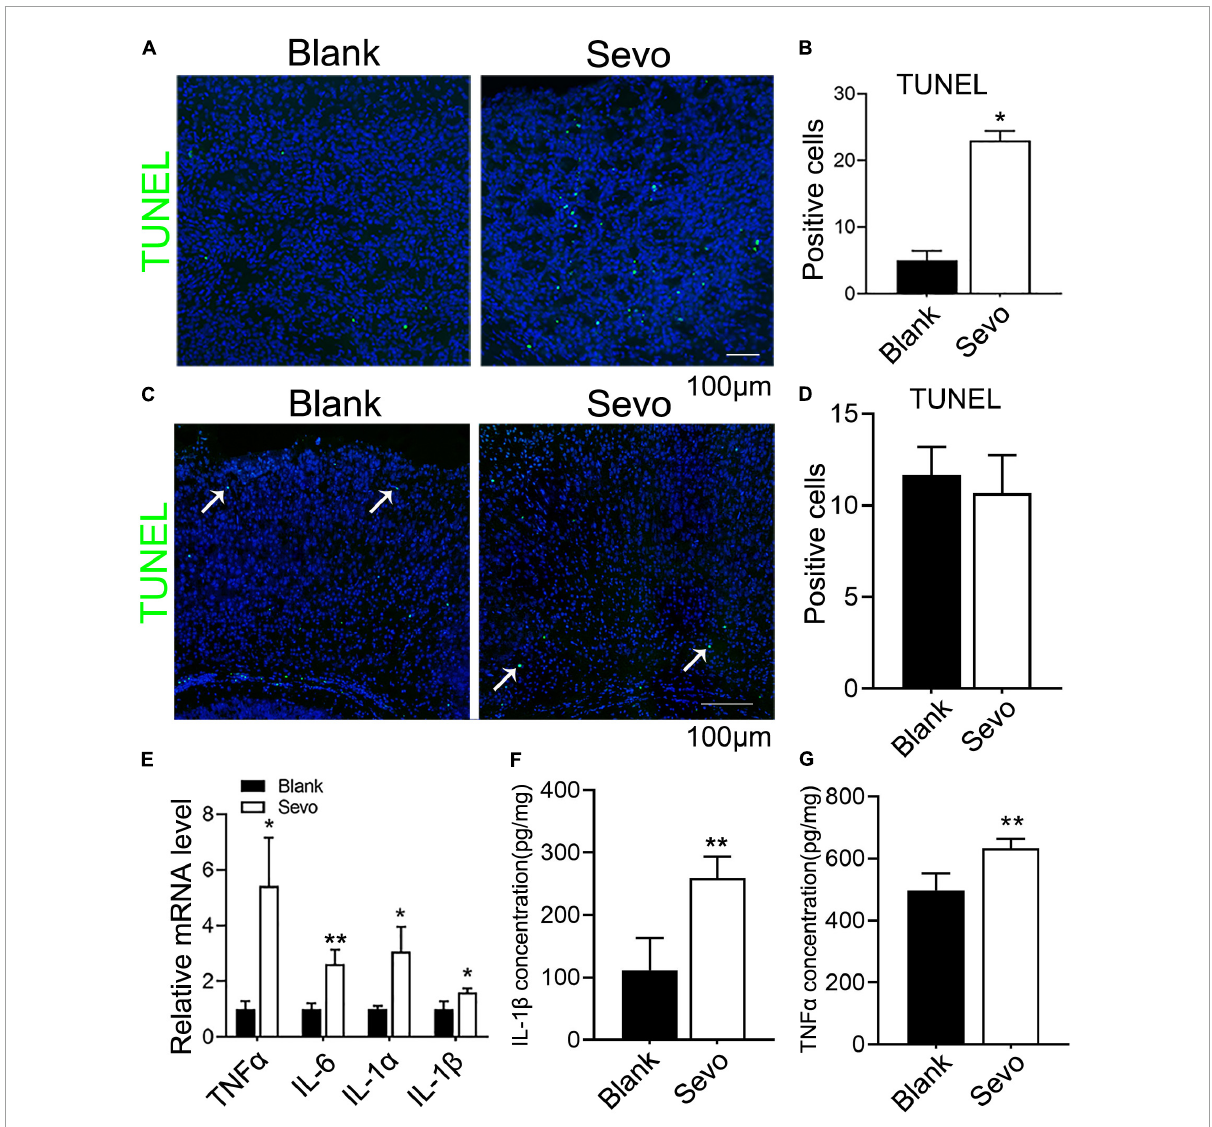
FIGURE1 Sevoflurane led to developing neuronal apoptosis via aggravating inflammatory factors expression. (A,B) TUNEL assay of brain tissue at 6 days mice of sevoflurane exposure for 2 h daily for 3 days and the quantitative analysis of TUNEL-positive cells. p = 0.039. N = 3. (C,D) TUNEL assay of brain tissues at 30 days mice of sevoflurane exposure and the quantitative analysis of TUNEL-positive cells. p = 0.54. N = 3. (E) Quantitative real-time PCR (qRT-PCR) of brain tissue at 6 days mice of control and sevoflurane exposure groups. p(TNF α ) = 0.018, p(IL-6) = 0.013, p(IL-1 α ) = 0.05, p(IL-1 β ) = 0.043. N = 3. (F,G) ELISA experiment with IL-1 β and TNF α of control and sevoflurane exposure groups. p(IL-1 β ) = 0.014, p(TNF α ) = 0.005. N = 4. Scale bar, 100 µ m. * P ≤ 0.05, ** P ≤